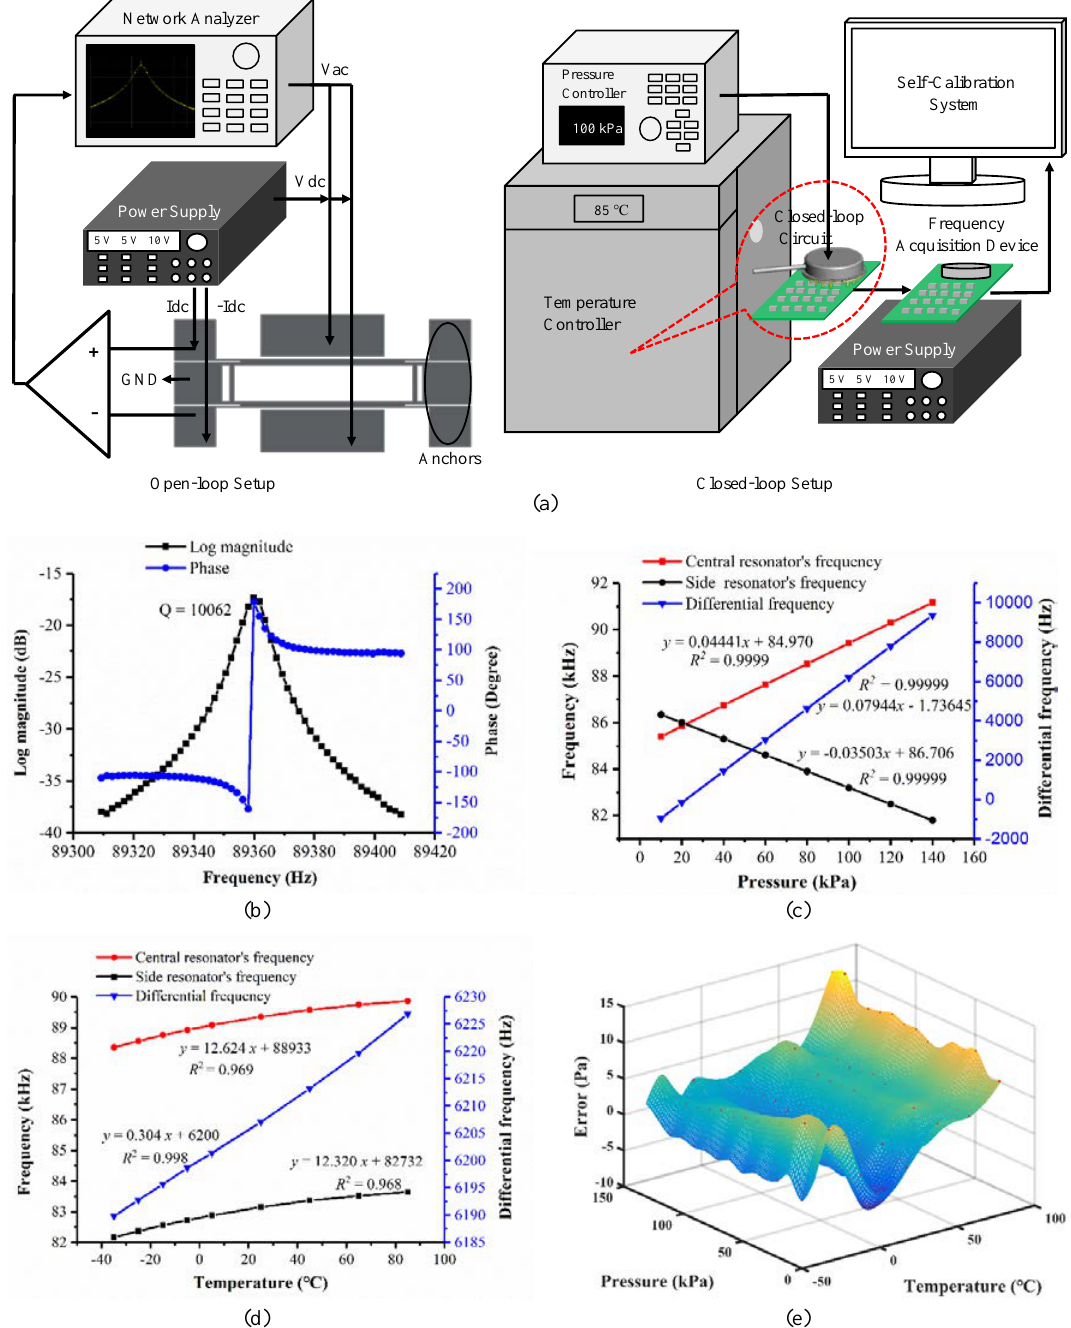
Figure 3. ( a ) Schematic of the experimental setup for both open-loop and closed-loop measurements of the proposed resonant pressure sensors. ( b ) Open-loop testing results where the quality factor and the phase of the developed resonant pressure microsensor were obtained. ( c ) Closed-loop testing results where the resonant frequency of the central resonator (f1) and side resonator (f2) and the differential output (f1–f2) of the developed resonant pressure microsensor versus applied pressure at 25 ◦ C. ( d ) The shift of resonant frequencies as a function of temperature in the range of − 35 ◦ C to 85 ◦ C under a predefined pressure of 100 kPa. ( e ) The errors of the developed resonant pressure microsensors in a pressure range of 10 kPa to 150 kPa and a temperature range of − 35 ◦ C to 85 ◦ C. The quantified errors were within ± 14 Pa, within 0.01% F.S.